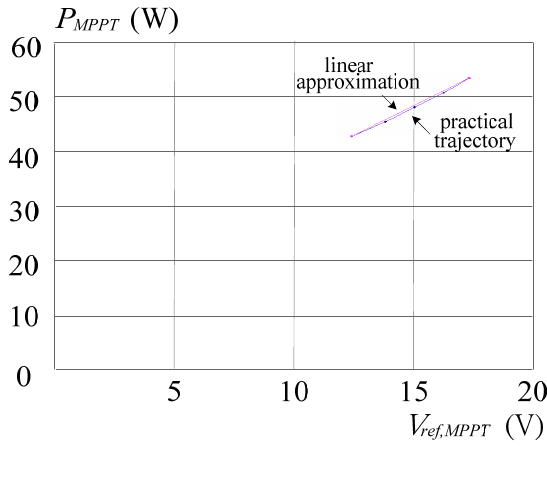
Figure 5. The relationship between P from 25 to 65